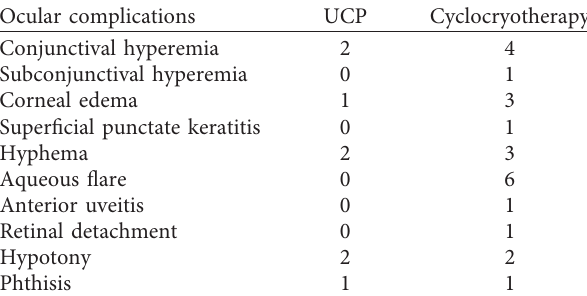
Table 5: Postoperative